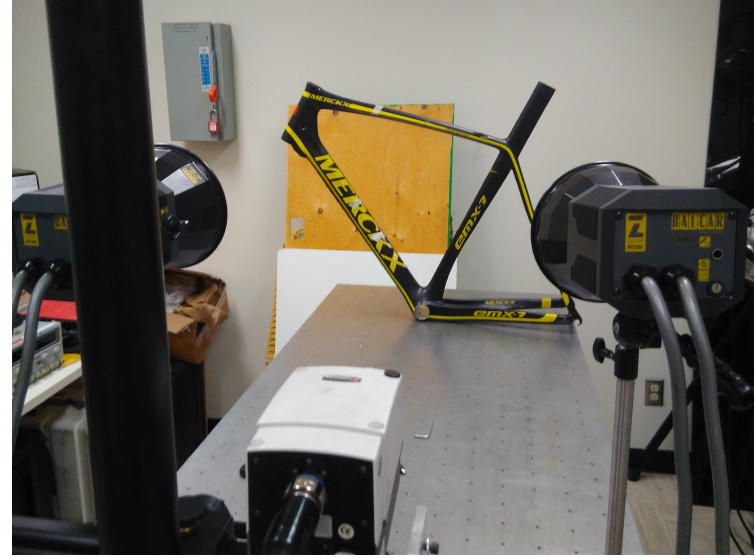
Figure 1. Photograph of the thermography measurement